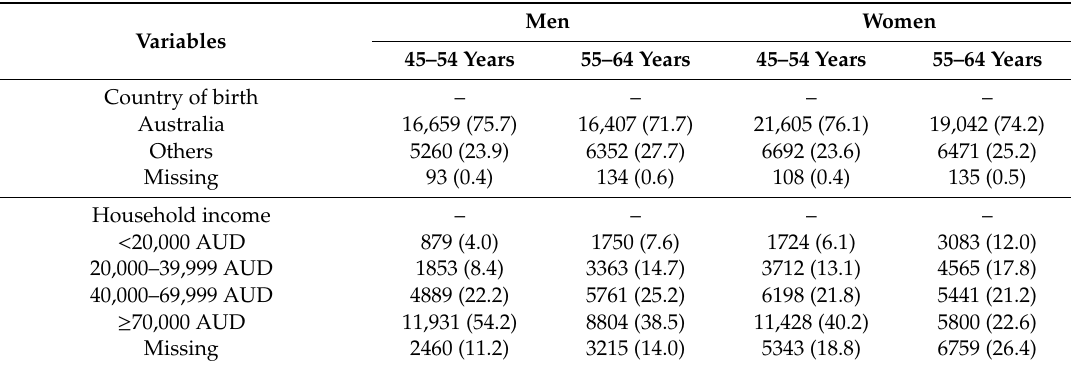
Table 1. Baseline characteristics of study